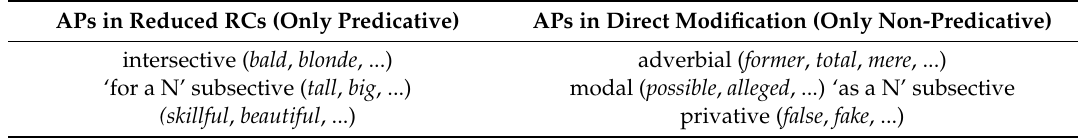
Table 1. APs in reduced RCs vs. APs in direct